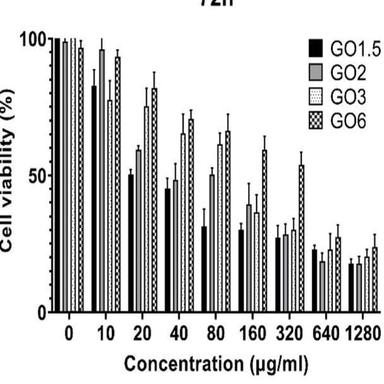
Comparing biocompatibility of different concentrations (GO1.5, GO2, GO3, and GO6) using MTT assay at 48 and 72 h.